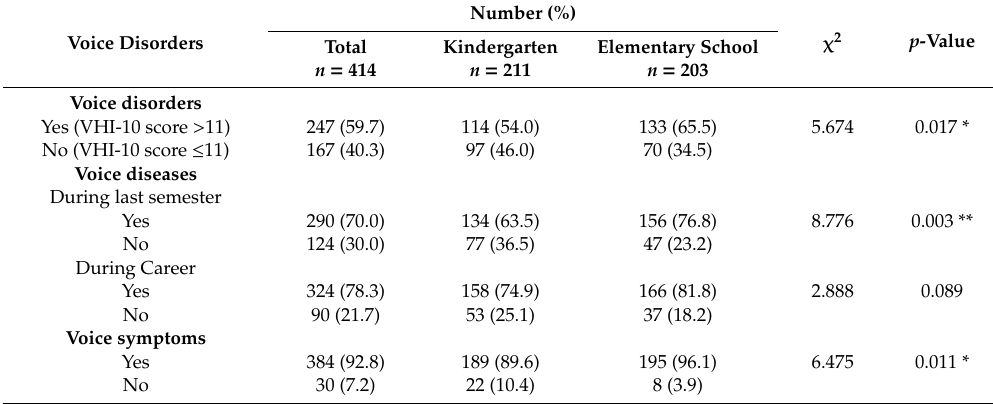
Table 2. Prevalence of voice disorders in early childhood teachers, Yancheng City, Jiangsu Province, China (2019), n =